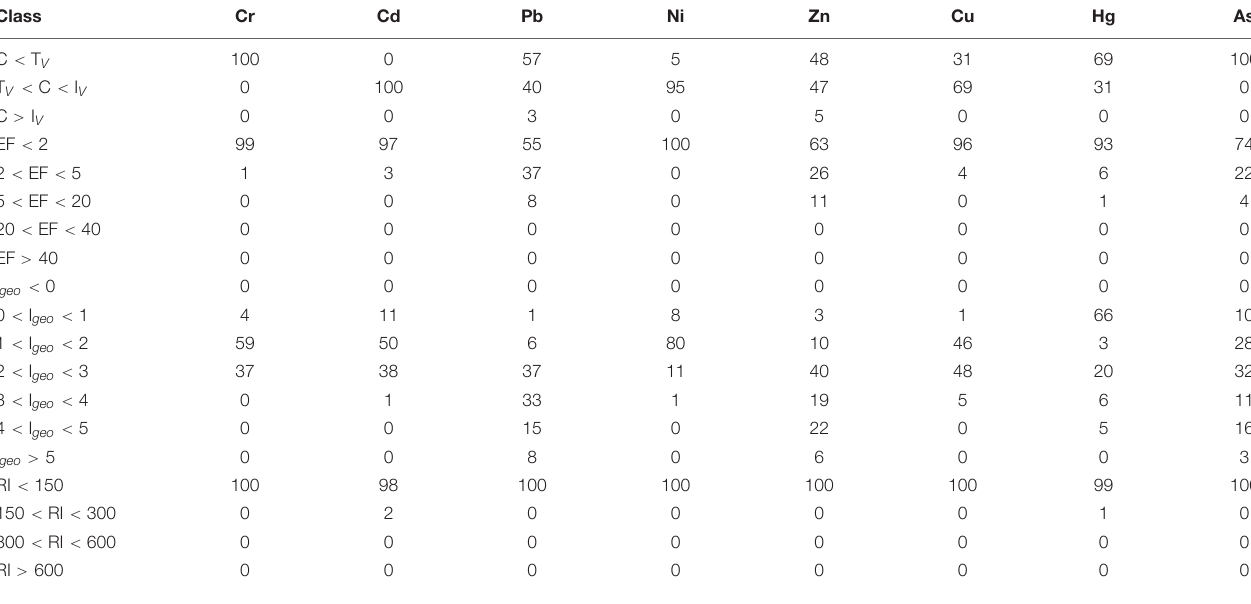
FIGURE 9 | Spatial distribution map of RI of soil at the former painting production facility. TABLE 6 | Percentage of pollution class distribution of individual